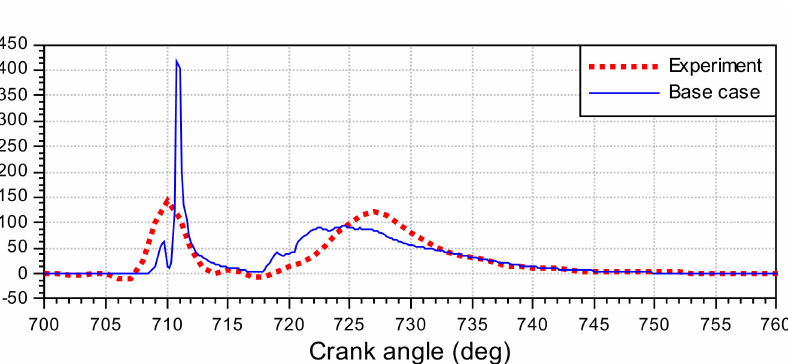
Figure 3. Calculated and experiment ROHR curves for biodiesel in an operated diesel engine at 1450 rpm and 25% of the full load mode.